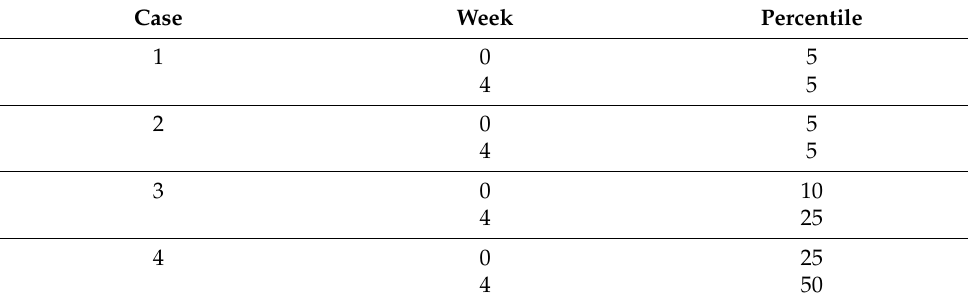
Table 2. Alberta Infant Motor Scale (AIMS) Percentile